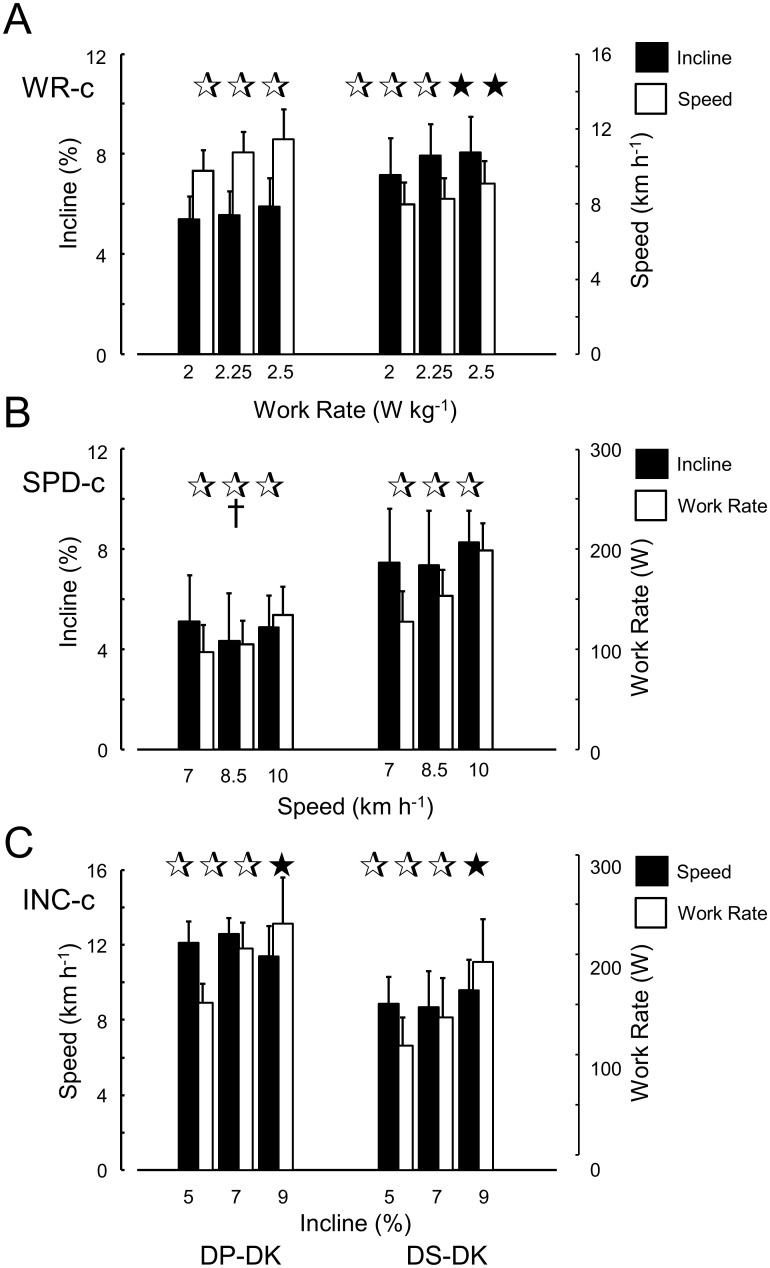
Incline, speed and work rate at sub-technique changes between double poling and double poling with kick (DP-DK) and between diagonal stride and double poling with kick (DS-DK).Separate findings are shown for each of three protocol subsets (Fig 2A-2C). Asterisks indicate significance (three: p<0.001; two p<0.01; one: p<0.05). The colour code (black-white) of the asterisk indicates the variable of interest, † indicates sex interaction.